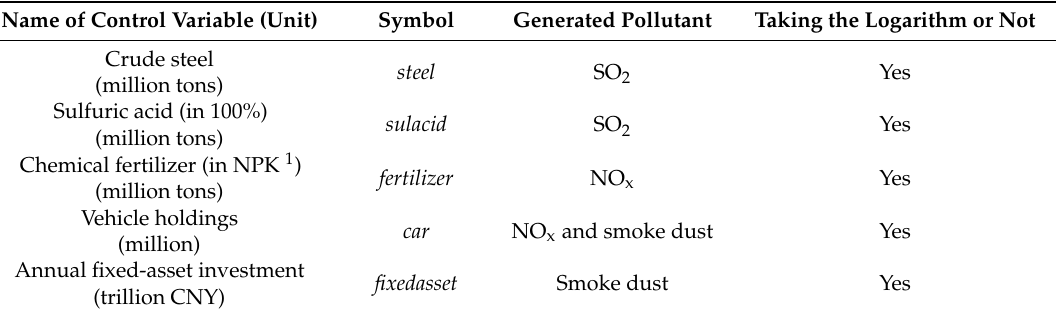
Table 2. Control variable set corresponding to the three emissions.